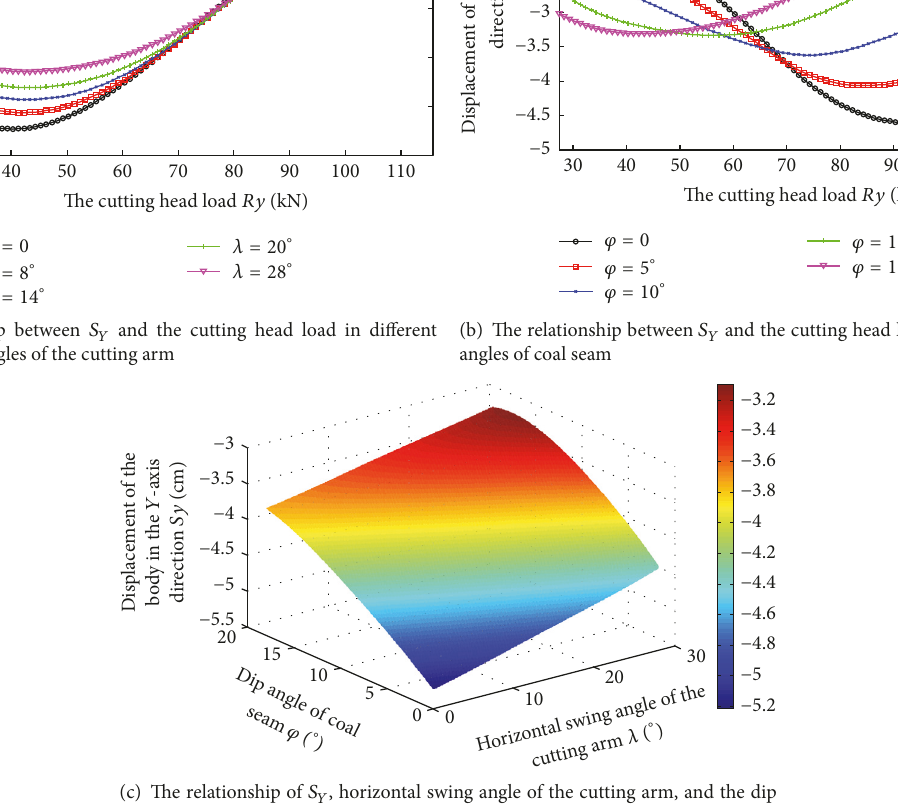
(c) The relationship of 𝑆 𝑌 , horizontal swing angle of the cutting arm, and the dip angle of coal seam Figure 12: The response results of displacement of the body in the 𝑦 -axis direction 𝑆 𝑌 .